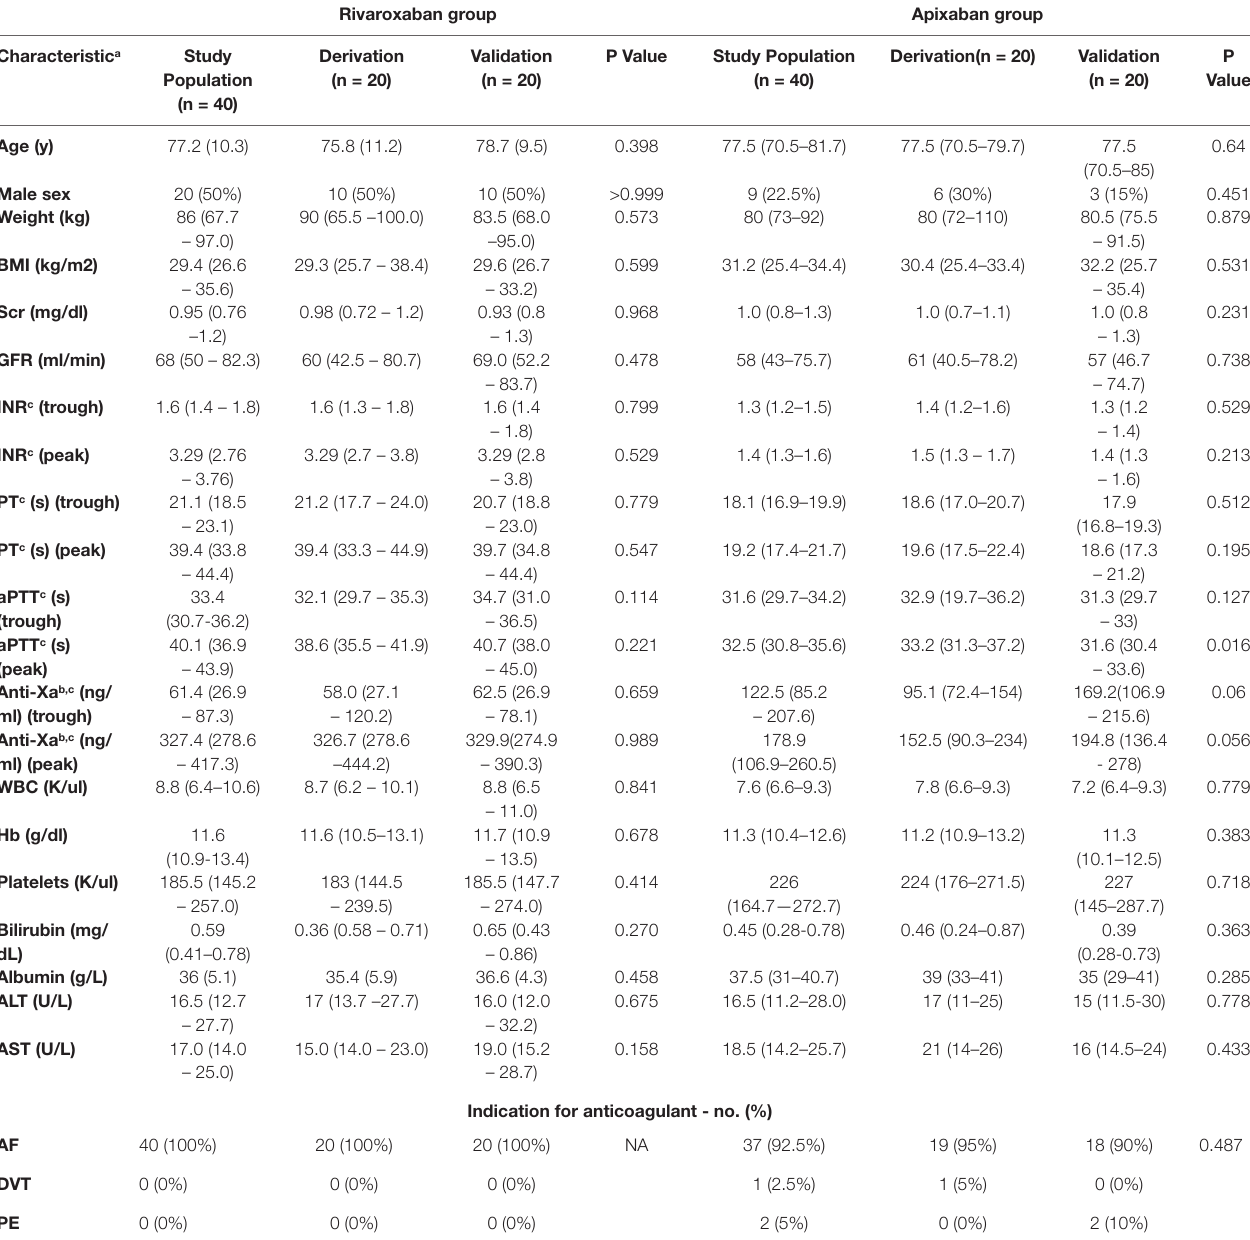
TABLE 1 | Rivaroxaban and apixaban treatment groups. Patient characteristics on admission and comparison between derivation and validation cohorts. Rivaroxaban group Apixaban